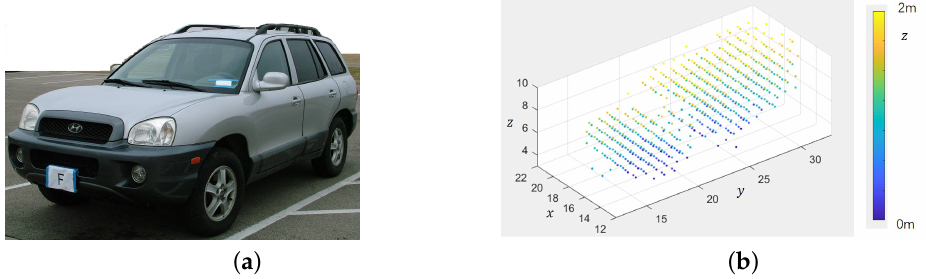
Figure 10. Comparison between real target of Vehicle F and 3D reconstruction result. ( a ) Optical image of Vehicle F. ( b ) Reconstructed 3D point cloud of Vehicle F.